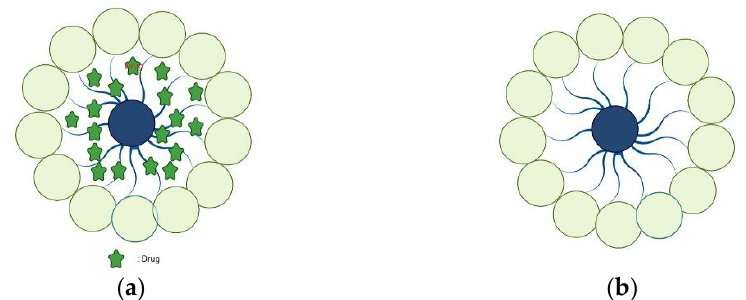
Figure 3. Blank polymer micelles ( a ) and drug-loaded polymer micelles ( b ).